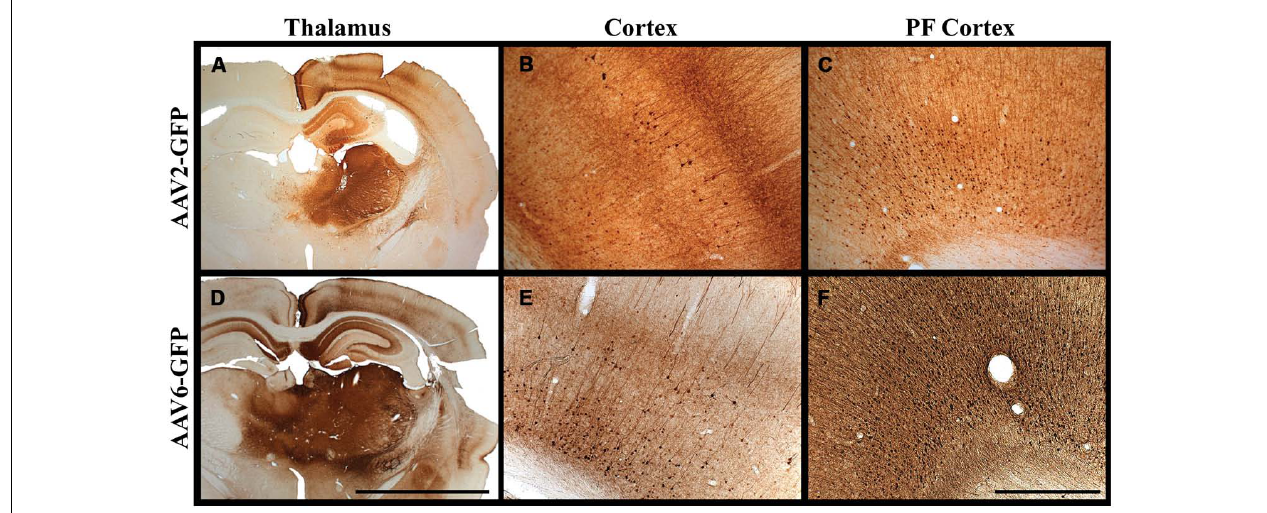
FIGURE 1 |Transgene distribution afterAAV2 andAAV6 delivery. (A–F) Unilateral injection into the thalamus of adult rats of either AAV2 or AAV6 resulted in widespread expression of GFP transgene in the neocortex and in pre-frontal regions distal to the site of injection. Scale bars: A,D = 5 mm; B,C,E,F = 1 mm.